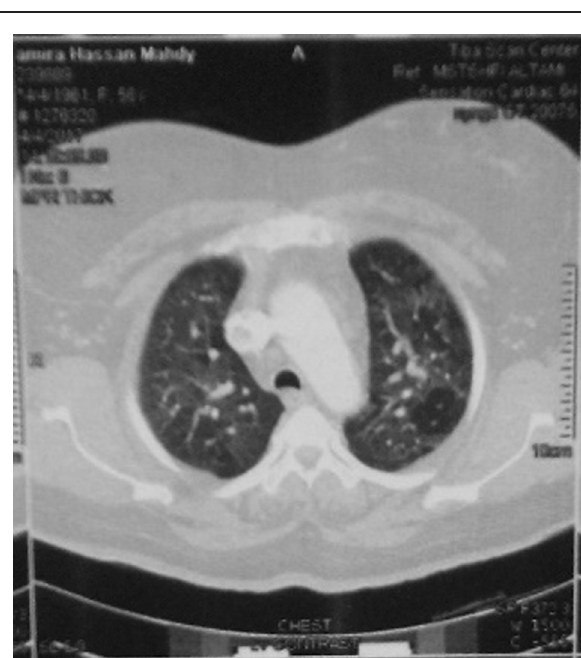
Ground-glass attenuation.